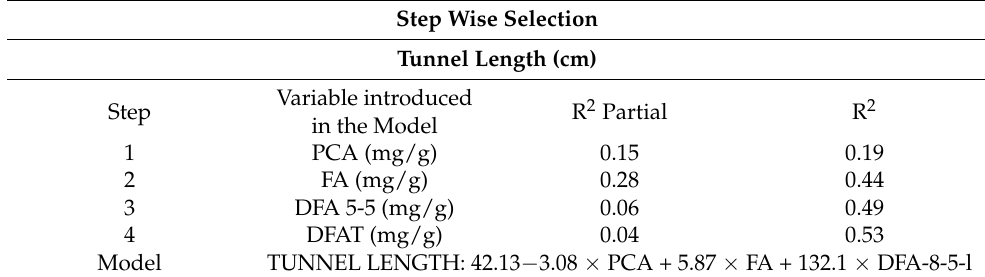
Table 3. Multiple linear regression models (using stepwise selection) of tunnel length on hydroxycin- namic